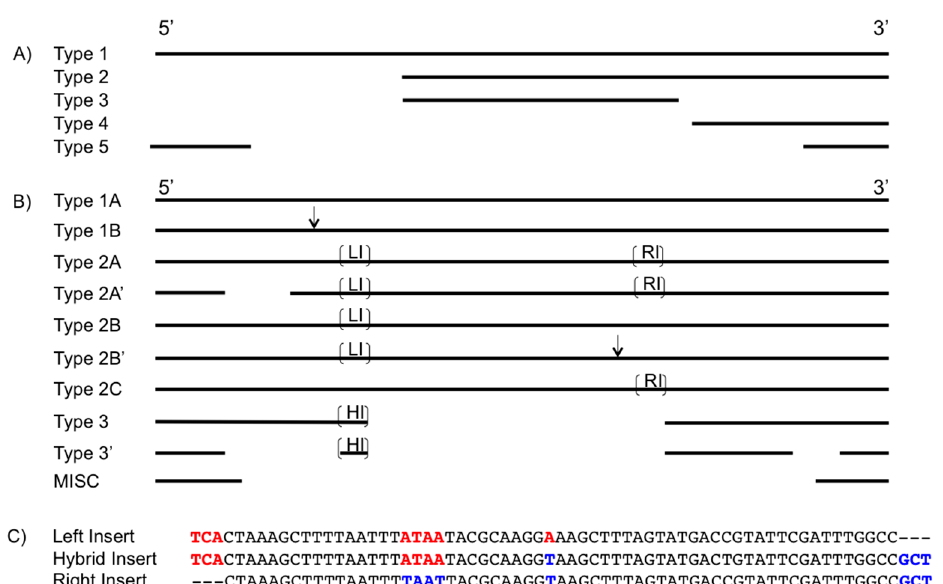
Figure 1. IS605 sequence visualization. Sequences are arranged from 5’ to 3’. Solid lines indicate nucleotide sequences and gaps indicate where the open reading frame (ORF) sequence is missing. Overlapping lines show where sequences are conserved between the different types. (A) IS605 tnpA ORF. (B) IS605 tnpB ORF. The down arrows of type 1B and type 2B’ show the relative position of a single nucleotide and putative IS21 insertion. The left insert (LI), right insert (RI), and hybrid insert (HI) are labeled with their abbreviation, placed in their relative location in the ORF, and shown with brackets. (C) IS605 tnpB ORF Inserts. Representatives of the left insert, right insert, and hybrid insert are shown in an alignment. Nucleotides common to the LI and HI are bolded in red text, while nucleotides common to the RI and HI are bolded in blue text.